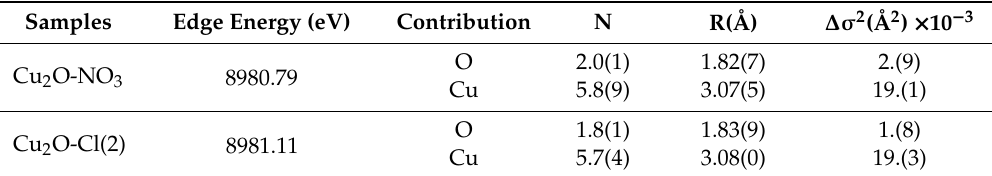
Table 3. Cu K-edge energy and extended X-ray absorption fine structure (EXAFS) fit parameters of the